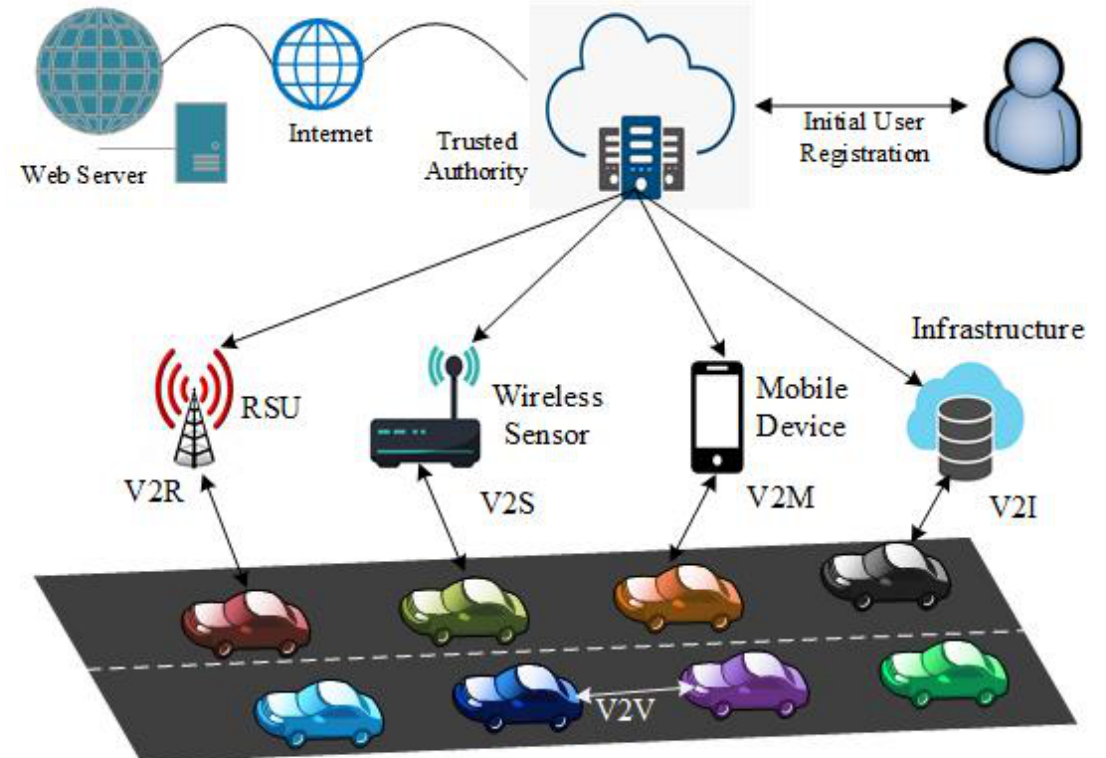
Figure 2. An interactive model of